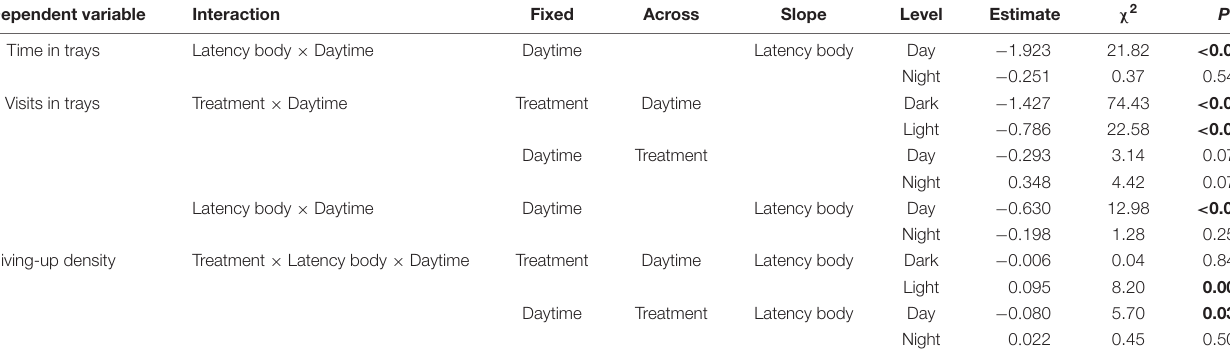
TABLE 3 | Results of post hoc analyses of linear mixed models via Wald chi-square ( χ 2 ) test. Dependent variable Interaction